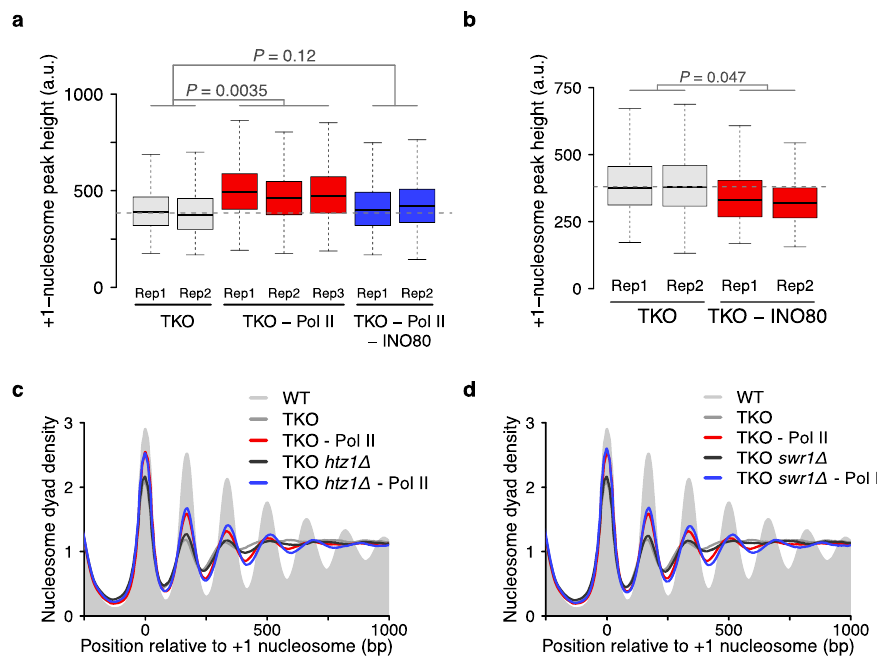
Fig. 5 IN080 positions + 1 nucleosomes independently of H2A.Z. a Box plots of peak heights measured for + 1 nucleosomes of ∼ 5000 genes in the indicated strains and replicates. TKO is a Rpb1-FRB tagged strain treated with vehicle for 1 h. The horizontal dashed line indicates the mean of two biological replicates of the TKO strain. P-values ( P ) represent statistical analyses performed with one-way Anova followed by post-hoc Tukey HSD test on the mean values of individual replicates. b Same as a , but for INO80 depletion in TKO cells. TKO reference: Ino80-GFP-FRB tagged TKO cells treated with vehicle. Statistical analysis was performed with two-tailed paired Welch ’ s t -test on the mean values of two replicates. c Deletion of H2A.Z ( htz1 Δ ; blue) has no deleterious effects on + 1 peak heights and nucleosome arrays upon Pol II depletion (red). The negative controls (grey and black) are the corresponding vehicle-treated Rpb1-FRB tagged strain. Pol II was depleted for 1 h. d Same as c , but for swr1 Δ . Data in c and d are averages of two or three biological replicates. Central lines in box plots indicate the median, the box shows the interquartile range, and whiskers indicate data points within 1.5 times of the interquartile range.